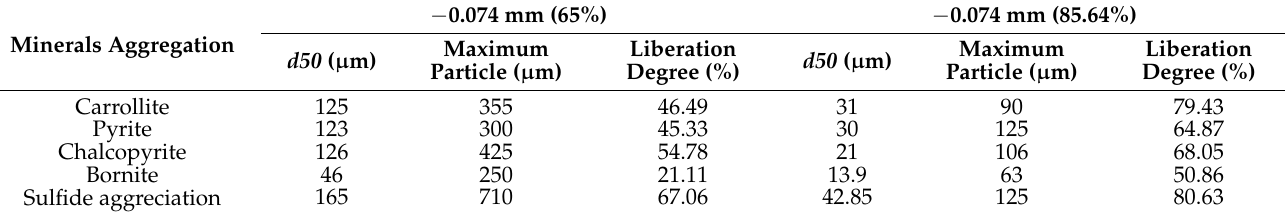
Table 6. Effect of grinding size on the liberation characteristic of sulfide minerals.